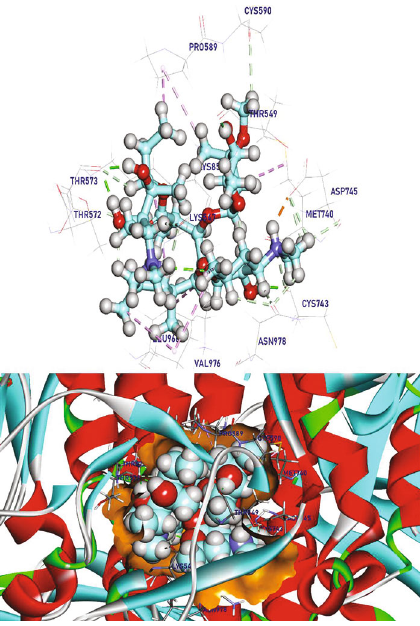
Figure 5: (Azithromycin) docked in RBD-SARS-CoV-2 Omicron spike protein, hydrogen bonds (green), and the pi interactions are represented in purple lines with mapping surface showing Azithromycin occupying the active pocket of RBD-SARS-CoV-2 Omicron spike protein.